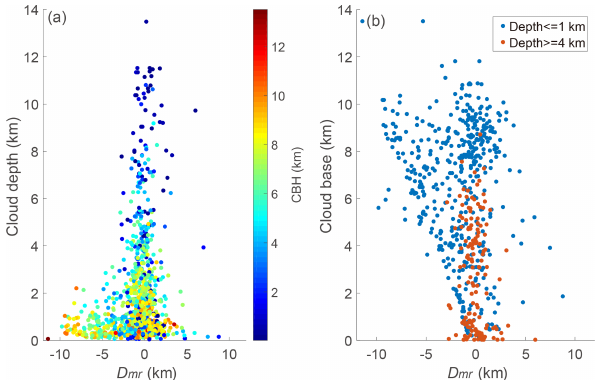
Figure 7. The relationship between (a) the D mr and cloud depth and (b) the D mr and the cloud base height (CBH) in cases of cloud depths < = 1km (blue) and > = 4km.